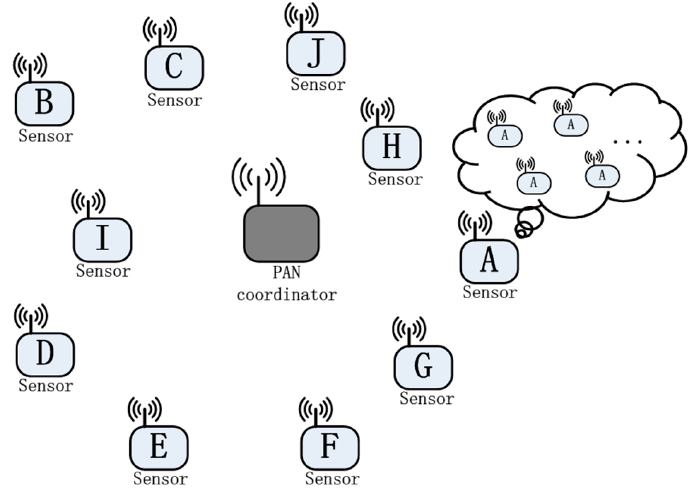
Figure 2. The sensor node’s equivalent process of surrounding network status.